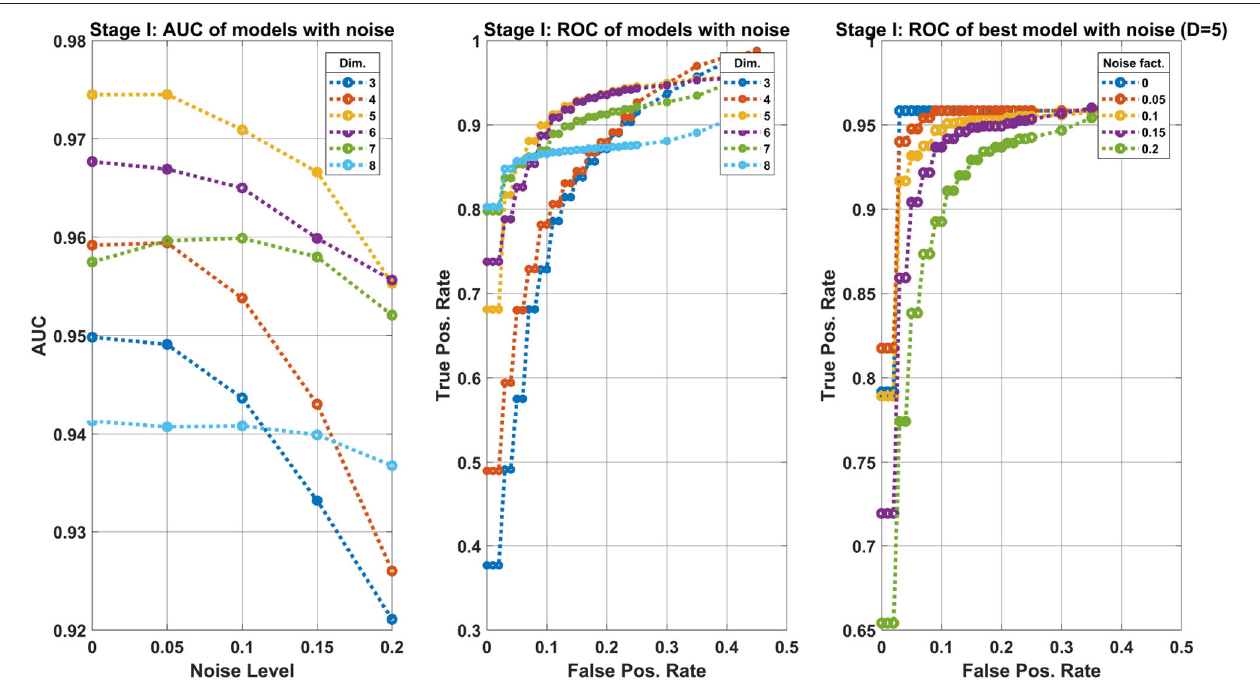
FIGURE 7 | Machine learning results of the first classification stage: separating Control from Transgenic classes. Left panel : AUC of models trained on different dimensional features space (see legend) at various noise levels (Equation 4). The 5-dimensional model is preferred. Middle panel : ROC of the same models as the left panel, where each point is the average over the noise levels. This curve allows us to prefer the model D = 5 assuming our operating point is FPR = 0.1. Right panel : Zoom in the best model, showing the performance degradation for various levels of noise added to the data.